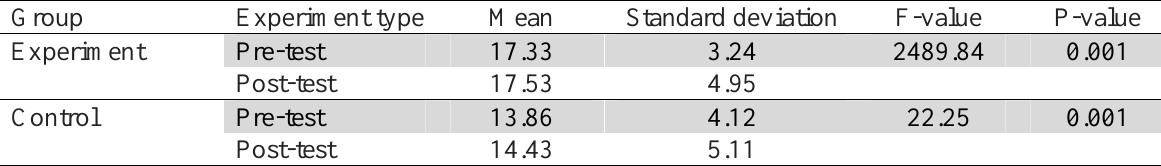
The results of testing FLE in terms of marital satisfaction Group